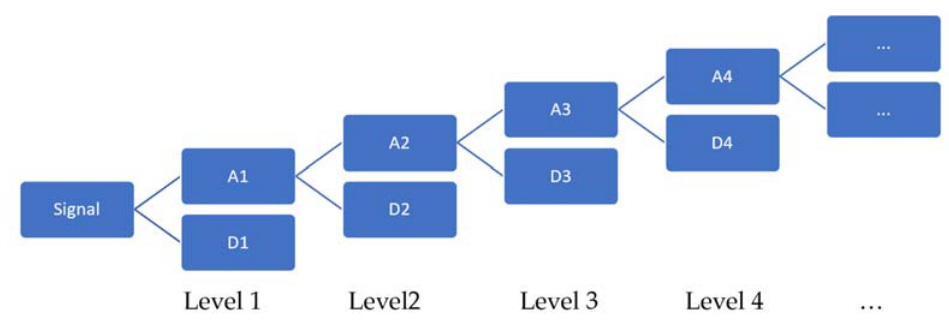
Figure 1. Wavelet